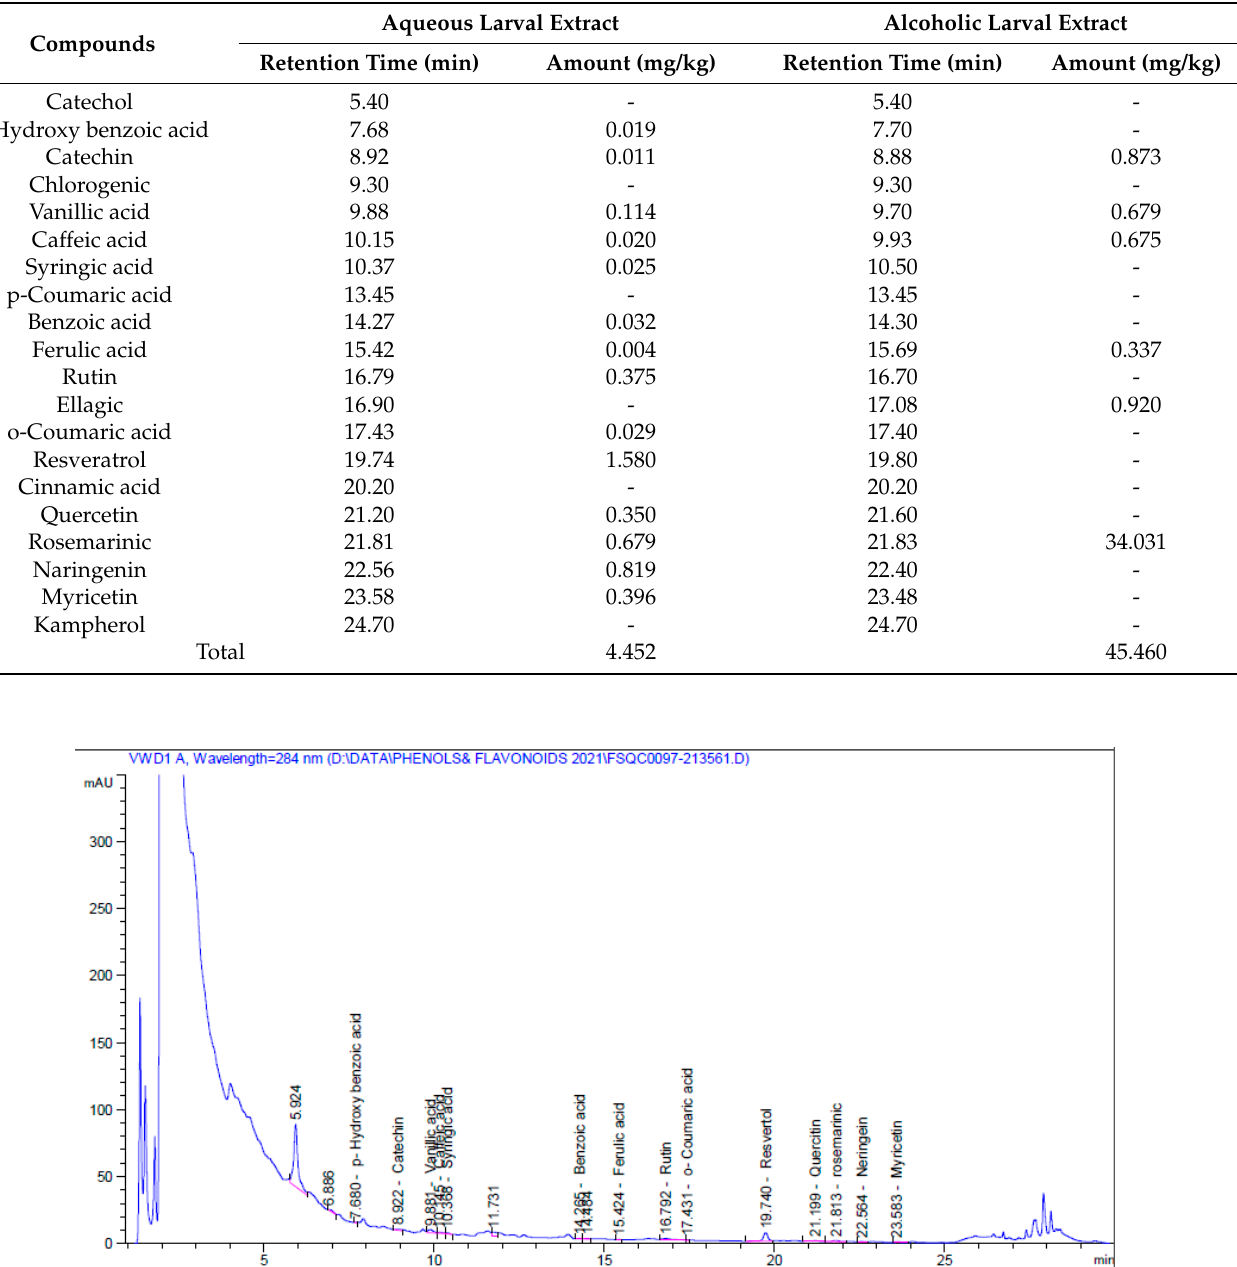
Table 2. Flavonoids and phenolic compounds composition of 5% aqueous and alcoholic larval extracts.